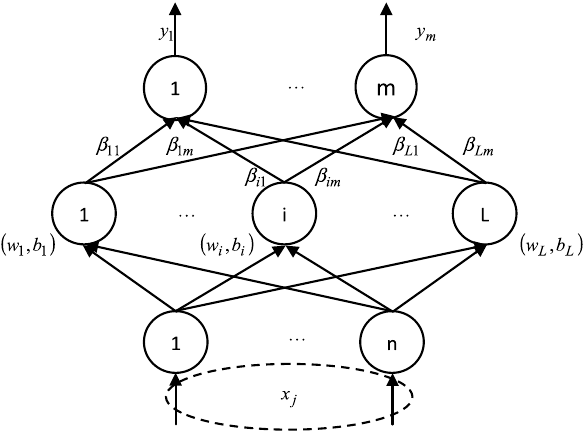
Fig. 1 Basic structure of ELM